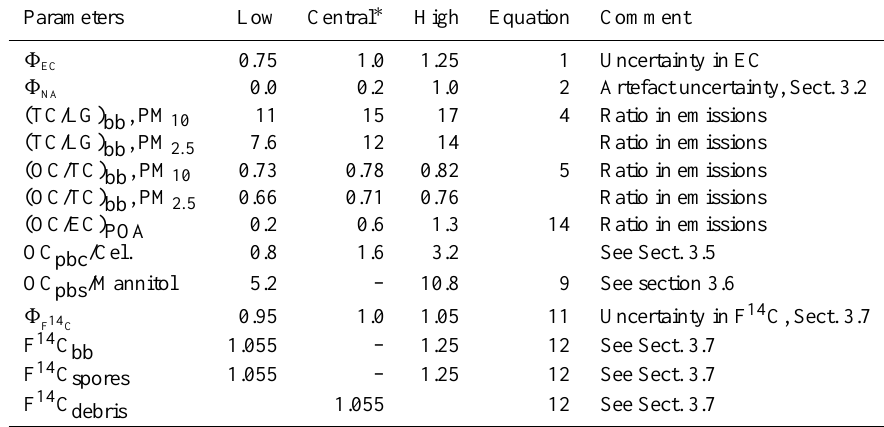
Table 3. Summary of uncertainty factors used in the LHS analysis. Low, central and high values are listed.